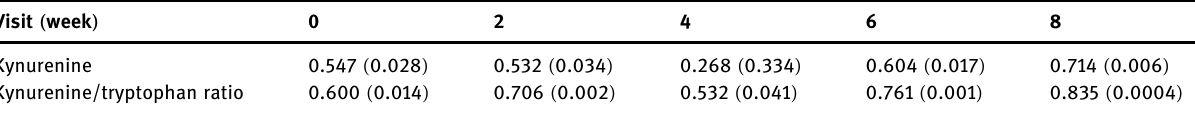
Table 3: Correlation ( Spearman ’ s rank correlation coe ffi cient ) of serum neopterin concentrations, and serum kynurenine concentrations and kynurenine/tryptophan ratio before and during the course of the treatment